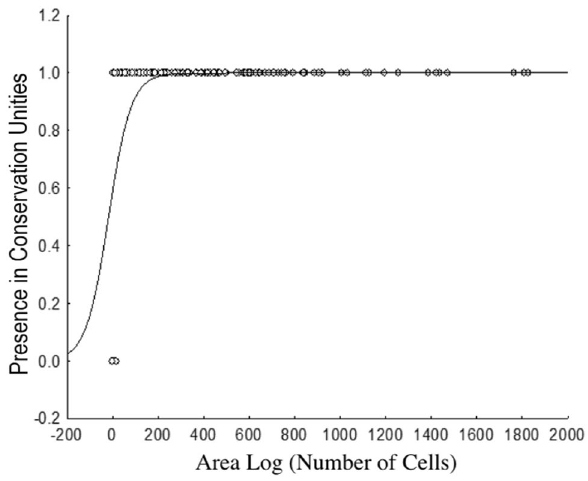
Figure 4. Logistic relationship between Gerromorpha occurrence and presence of these species in CUs. Four species are located outside the protected area of the biome, where zero (0) means location outside a CU and one (1) means presence in a